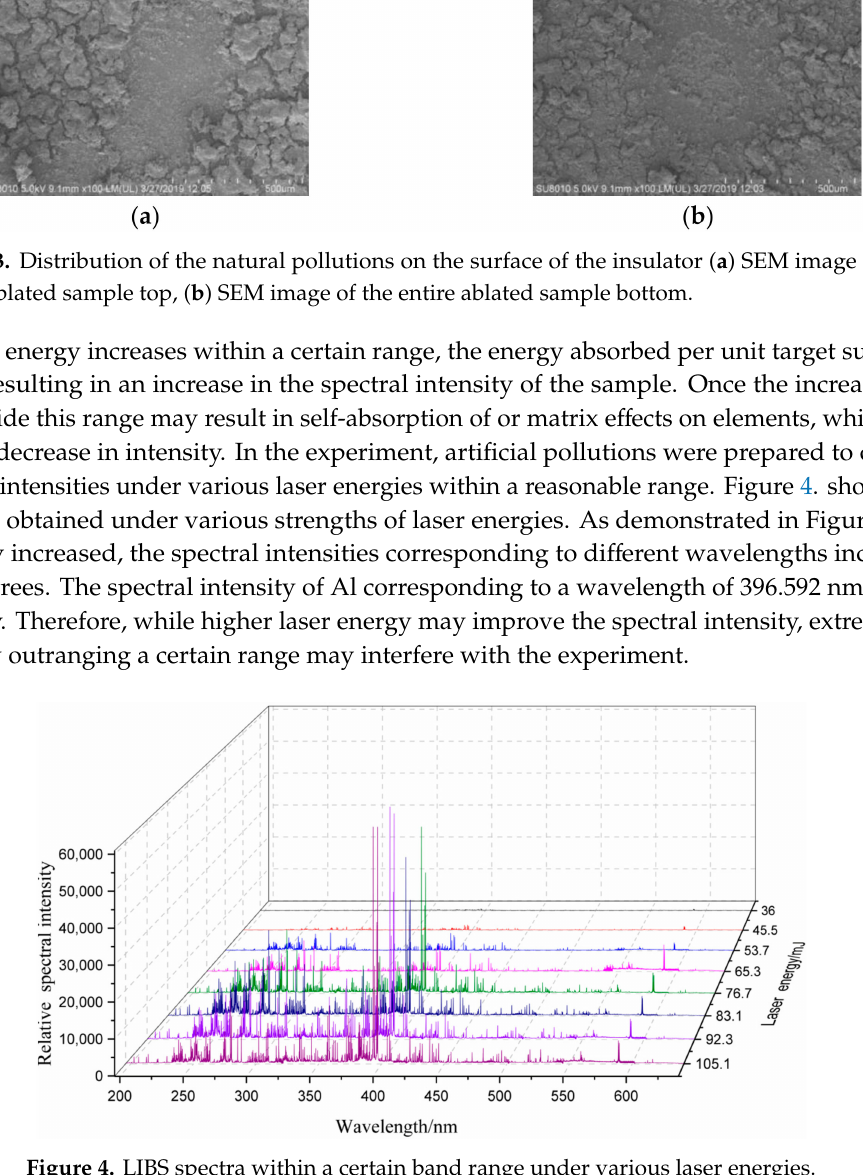
Figure 4. LIBS spectra within a certain band range under various laser